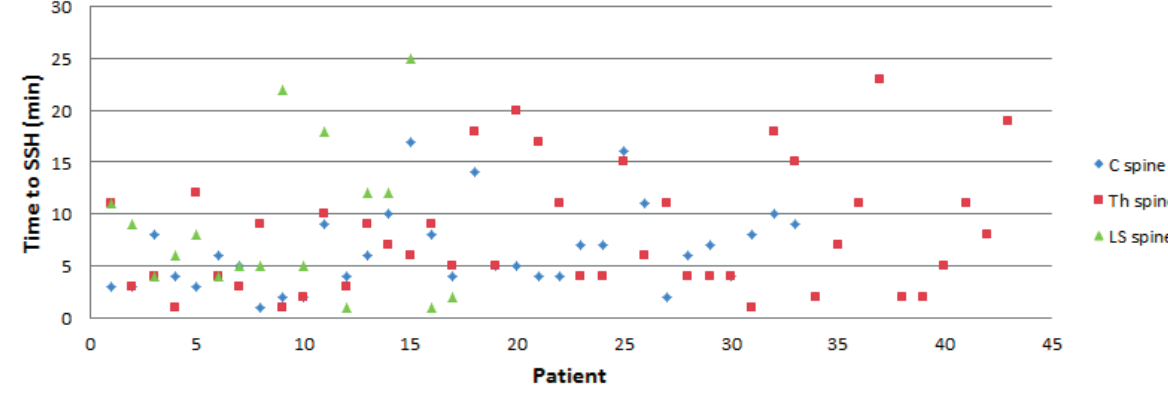
The mean recorded SSH was 1.6±0.66, 1.43±0.33 and 1.46±0.47 mm/deg for the C, Th, and LS spine